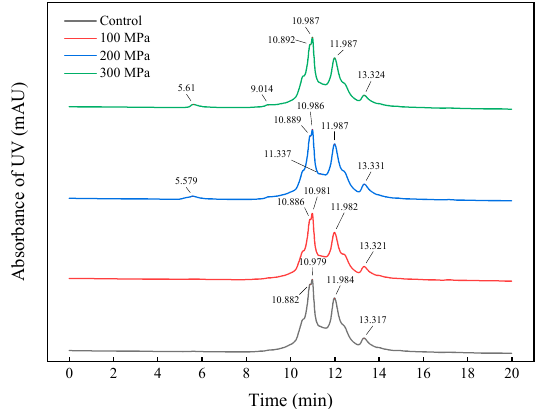
Figure 8. Effect of HHP pretreatment on the molecular-weight distribution profiles of RBPH. HHP: high hydrostatic pressure; RBPH: rice bran protein hydrolysates. Control, 100 MPa, 200 MPa, and 300 MPa represent RBPH samples subjected to 0, 100, 200, and 300 MPa pretreatment, respectively. All the HHP pretreatments were conducted at 25 °C for 30 min.